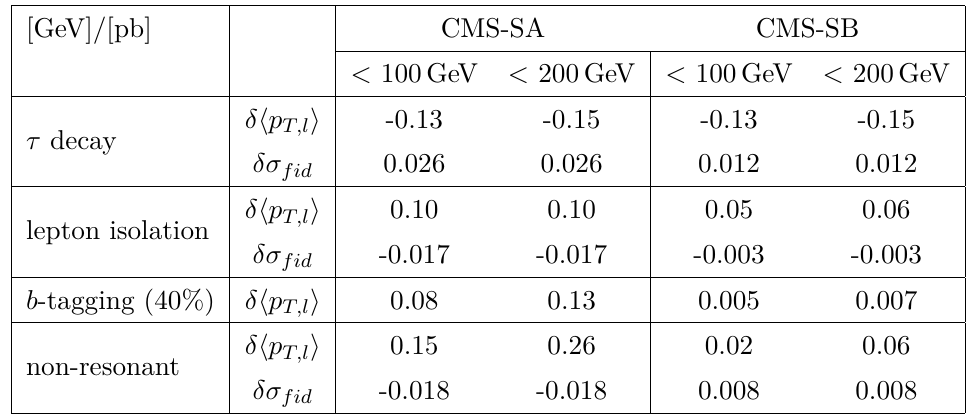
Table 8 . Changes of the average transverse momentum of the charged lepton and of the fiducial cross section within the two fiducial regions, when including contributions from τ decay, applying lepton isolation, varying b -tagging efficiency, and including non-resonant